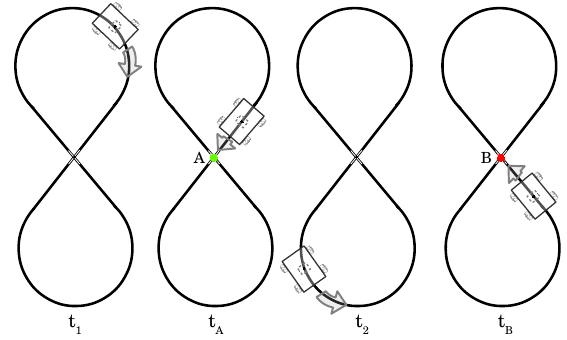
Figure 18. AGV trajectory and its reference points to data